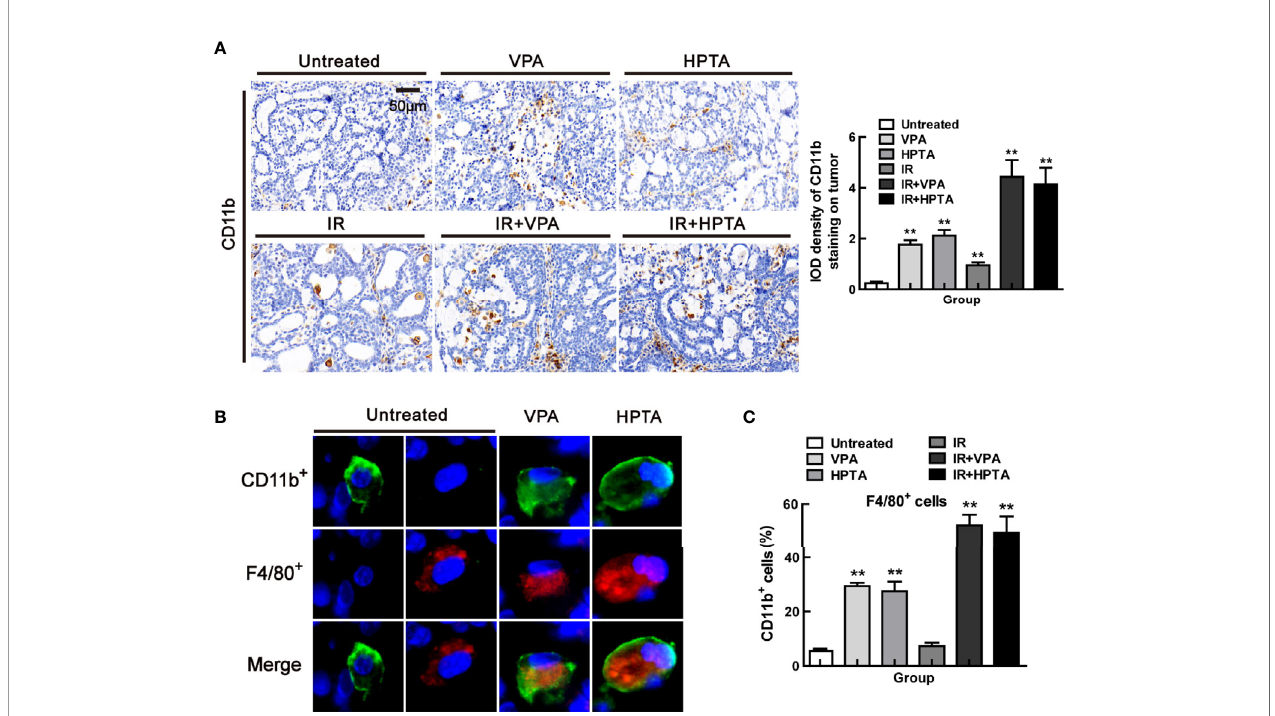
FIGURE 3 | VPA/HPTA regulates myeloid-derived macrophages to enhance radiotherapy effect in breast cancer at the early stage of treatment in vivo (A) IHC was performed on tumor sections with the myeloid marker CD11b to assess in fi ltration, representative quantitation and images are shown. Immuno fl uorescence co- staining of myeloid derived cells (CD11b+: green) and macrophages (F4/80+: red), and representative images (B) and quantitation (C) are shown. Each data point in the graphs was from three independent experiments (mean ± SD). P -values were calculated by Student ’ s t-test (* P < 0.05, ** P <